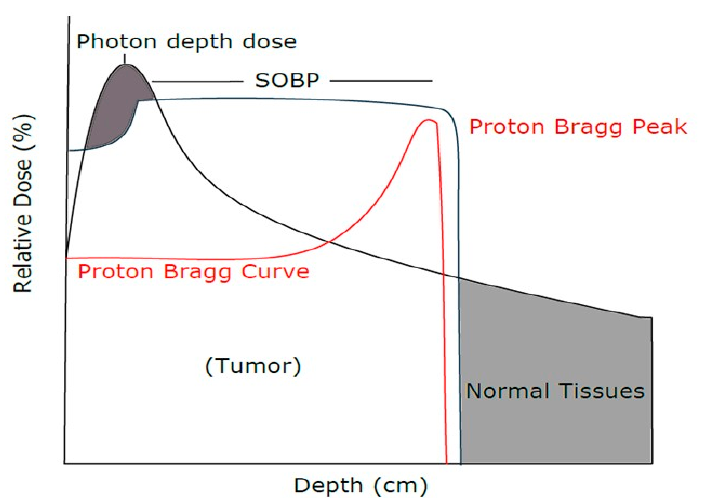
Figure 1. Comparison of photon and proton dose distribution in normal and tumor tissues. Ionizing radiation like proton and photons cause cell death either by directly and/or indirectly damaging the nuclear DNA, which leads to impairment of the DNA repair path- way. The lethality of a charged particle like protons, on a cell by nuclear DNA damage